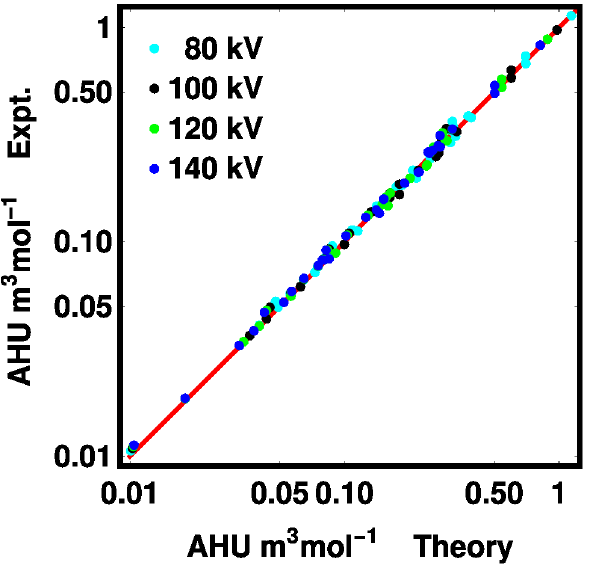
Fig 4. Experimental values for the molar Hounsfield unit potency is shown for both theory and experiment. The red line is the identity function. The colors code the tube voltages as: 80 kV (cyan), 100 kV (black), 120 kV (green), and 140 kV (blue). The plotted points are given in tabular form with the public